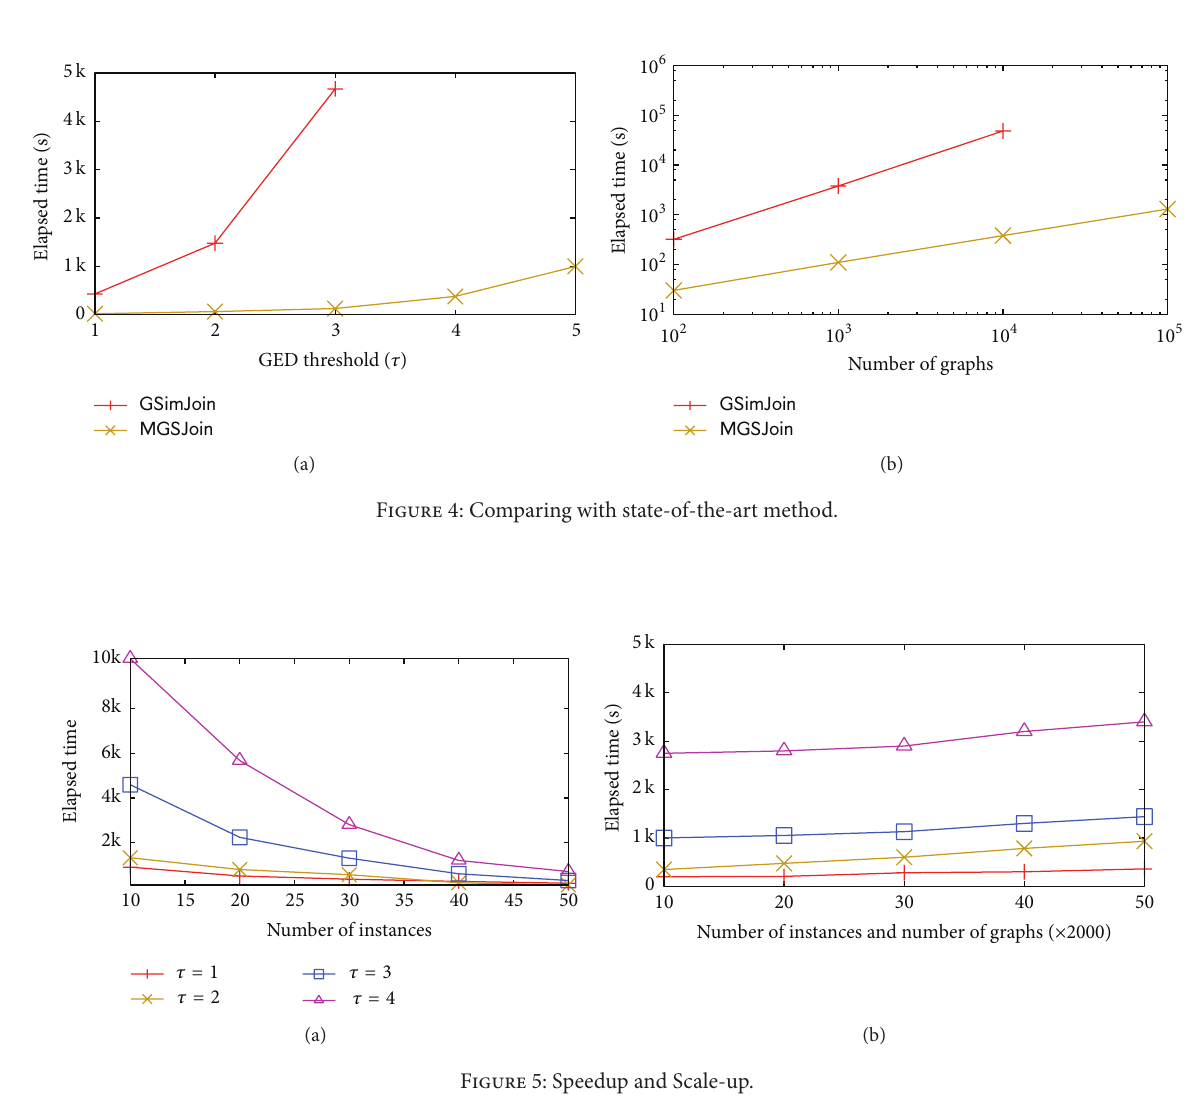
Figure 3: Evaluating verification.